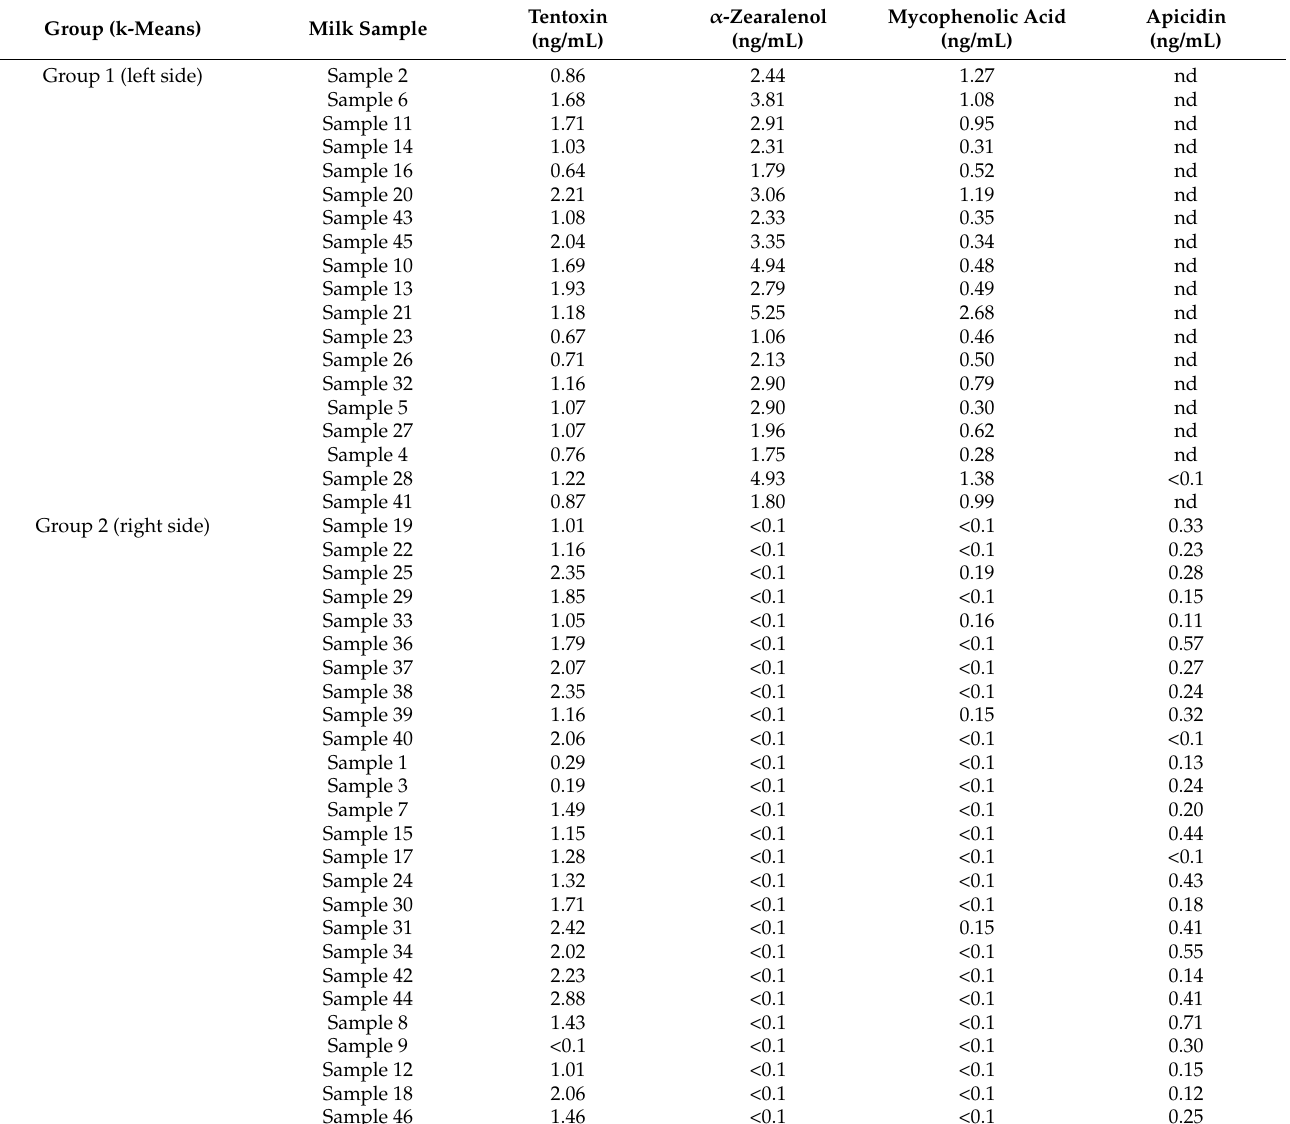
Table 2. Semiquantitative analysis based on HRMS (UHPLC-Orbitrap-MS) of tentoxin, α -zearalenol, mycophenolic acid, and apicidin in the different milk samples according to the main groups highlighted by the k-means clustering approach. nd = not